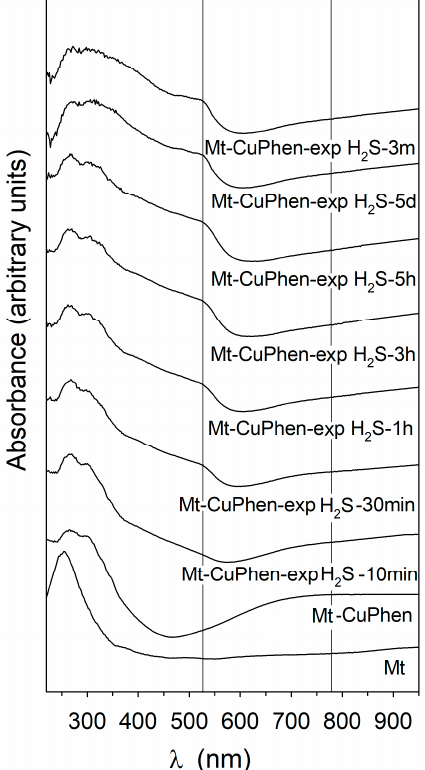
Figure 2. Diffuse–reflectance (DR) UV–Vis spectra of Mt-CuPhen and of Mt-CuPhen exposed to H 2 S for different times. Curves were shifted on the y-axis for sake of clarity. Lines at λ = 520 nm and λ = 780 nm mark features discussed in the text.